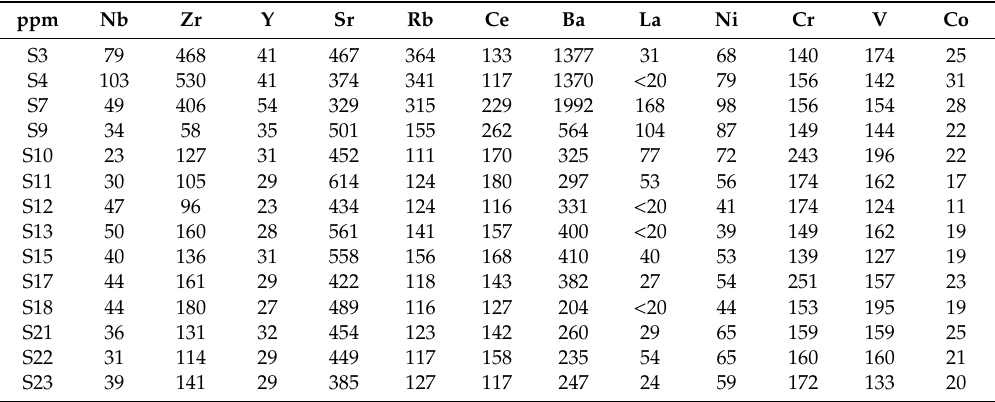
Table 6. Chemical composition of trace elements of the architectural earthenwares by XRF analysis, expressed in